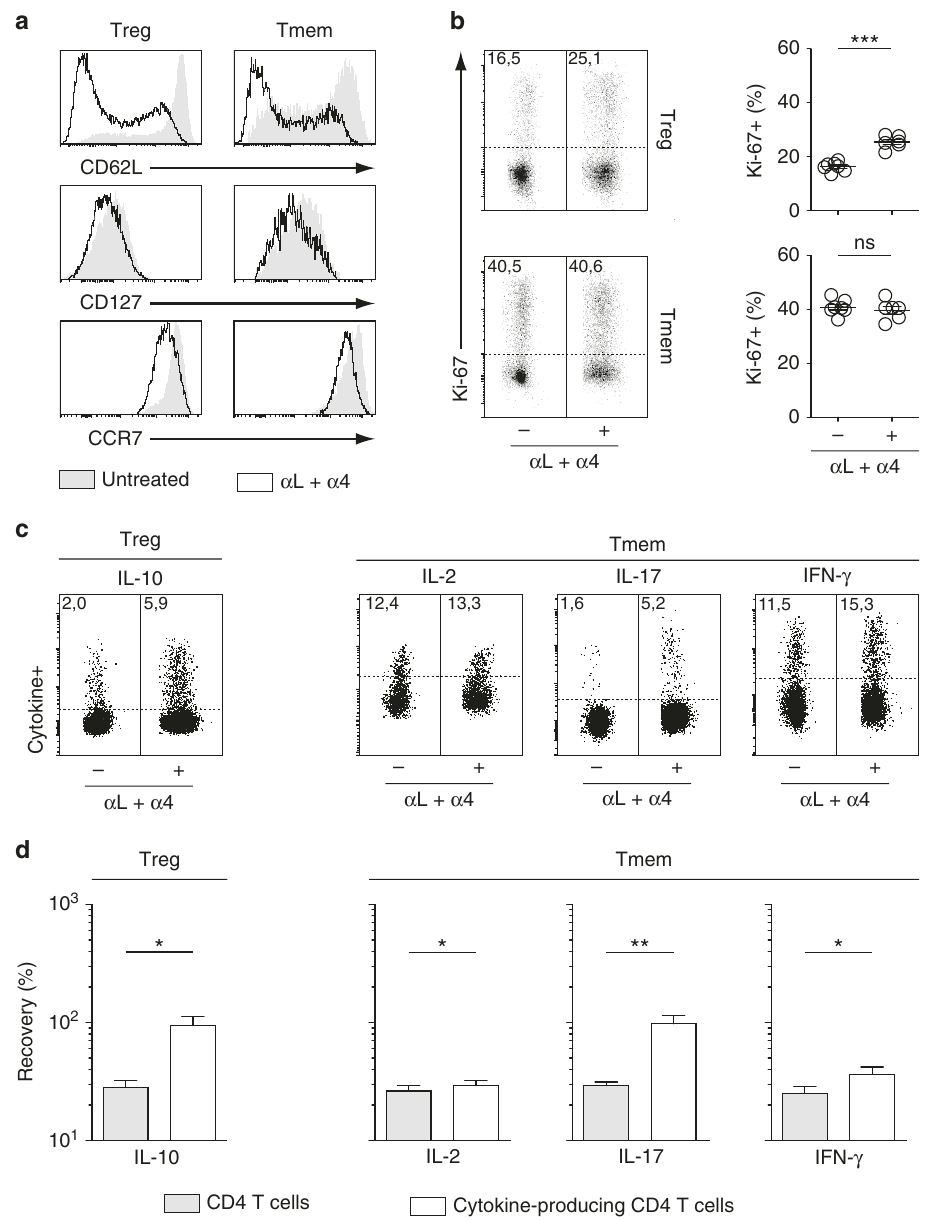
Fig. 4 pLN-resident CD4 T cells exhibit an effector phenotype. 6 – 12-week-old C57BL/6 Foxp3-GFP mice were injected or not i.p. with 200 μ g of anti-LFA-1 ( α L) and anti-VLA-4 ( α 4) Abs. Forty-eight hours later, pLNs were harvested and analyzed. a CD62L, CD127, and CCR7 fl uorescence histograms of CD4 Treg and CD4 Tmem cells from a representative treated and a representative control C57BL/6 Foxp3-GFP mouse. b Representative Ki-67 expression by CD4 Treg and CD4 Tmem cells from treated and control mice. Quanti fi cation is shown on the right side of the panel (unpaired t -test). Each dot represents an individual mouse. c Representative IL-10 expression by CD4 Treg cells and representative IL-2, IL-17, and IFN- γ expression by CD4 Tmem cells from treated and control mice. d Quanti fi cation of cytokine production by CD4 Treg and Tmem cells is shown as means ± SEM with paired t -test. The percentage of recovery for a given cytokine was calculated by dividing the absolute numbers of cells expressing this cytokine in treated mice by the mean absolute number of cells expressing this same cytokine in untreated animals (white bars). The gray bars correspond to the recovery of total CD4 Treg